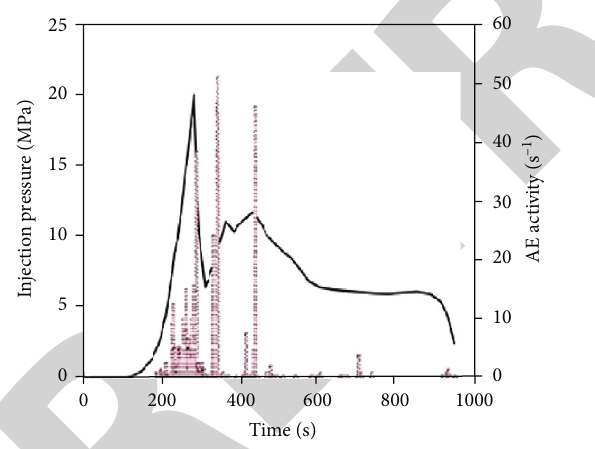
Figure 6: The injection pressure curve and AE activity of Sample